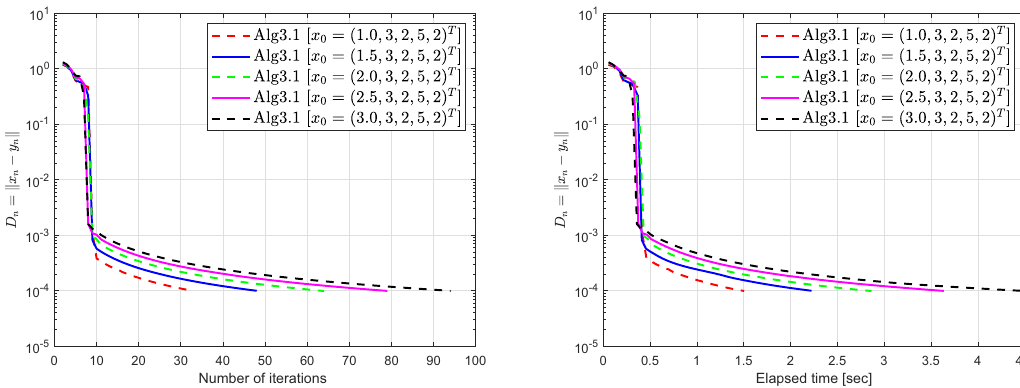
Figure 1: Example 6.1: Choosing di ff erent initial points and behavior for Algorithm 3.1 in [ 31 ]